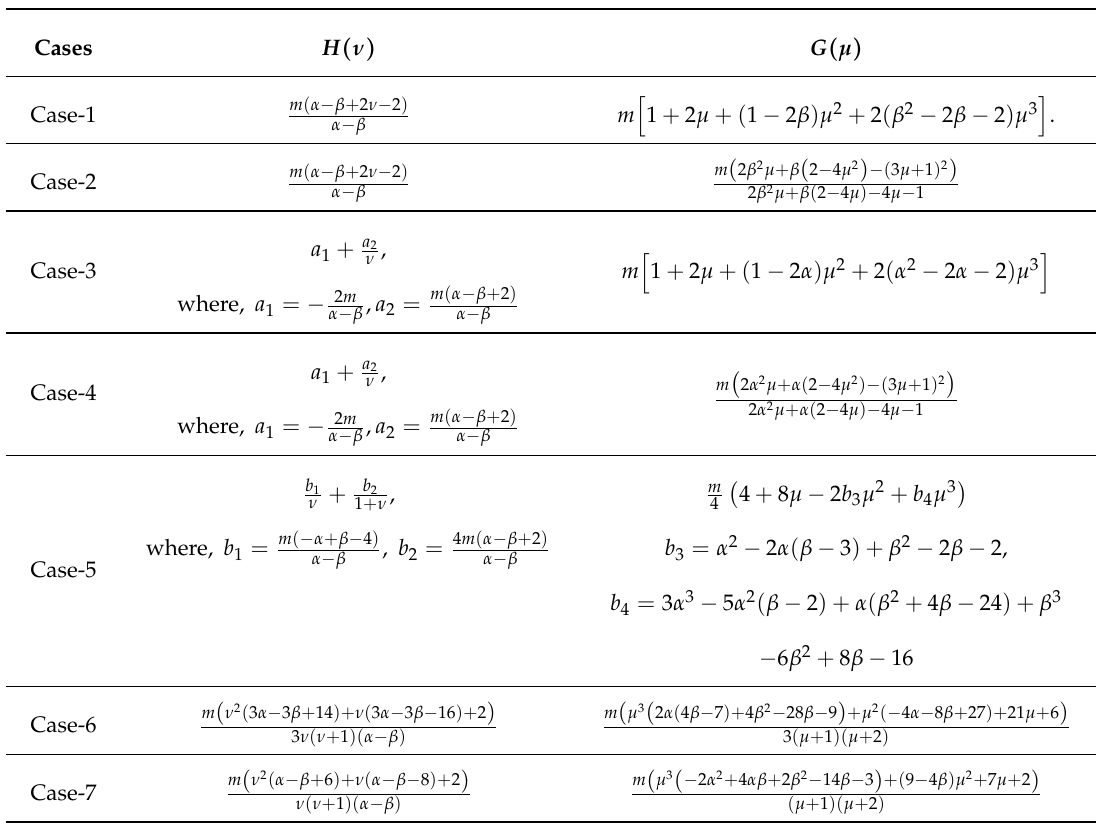
Table 1. Some special cases of the proposed scheme